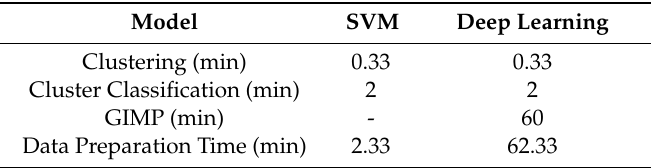
Table 9. SVM and deep-learning data preparation time per